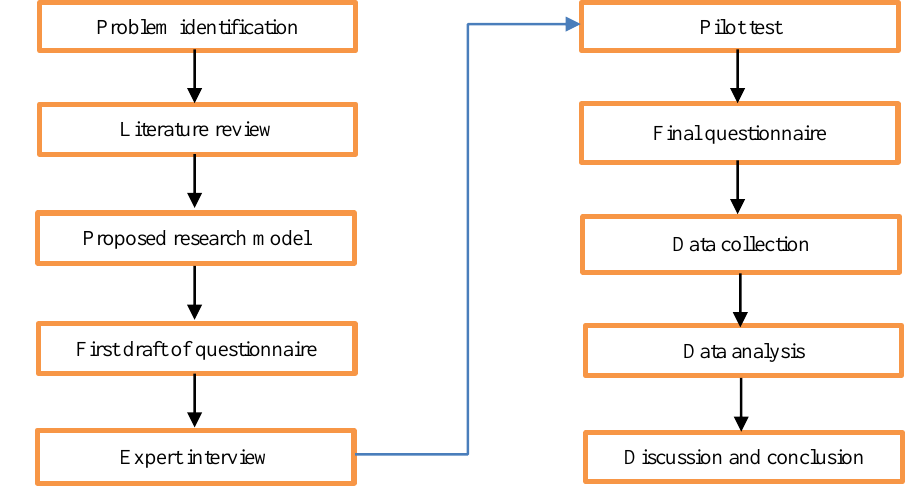
Figure 2. Flowchart of the study.